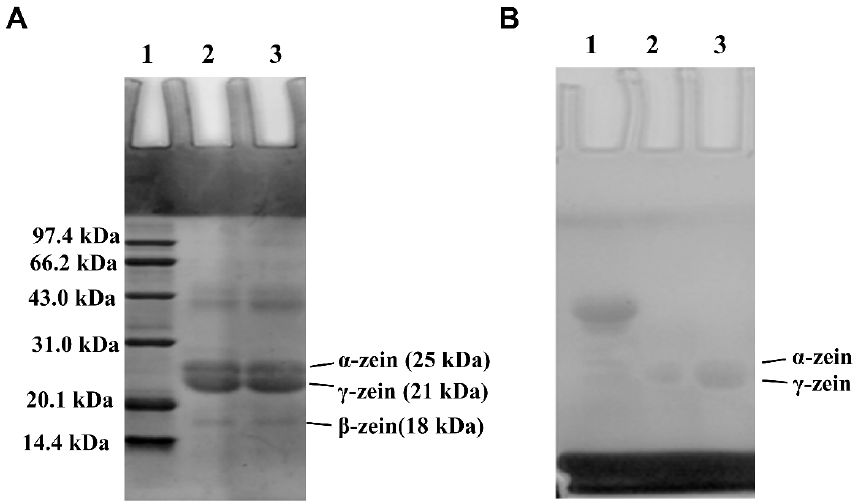
Figure 3. SDS–PAGE of zein and G-zein. ( A ) Coomassie blue staining for protein markers (lane 1), zein (lane 2), and G-zein (lane 3). ( B ) Schiff staining for horseradish peroxidase (lane 1), zein (lane 2), and G-zein (lane 3).